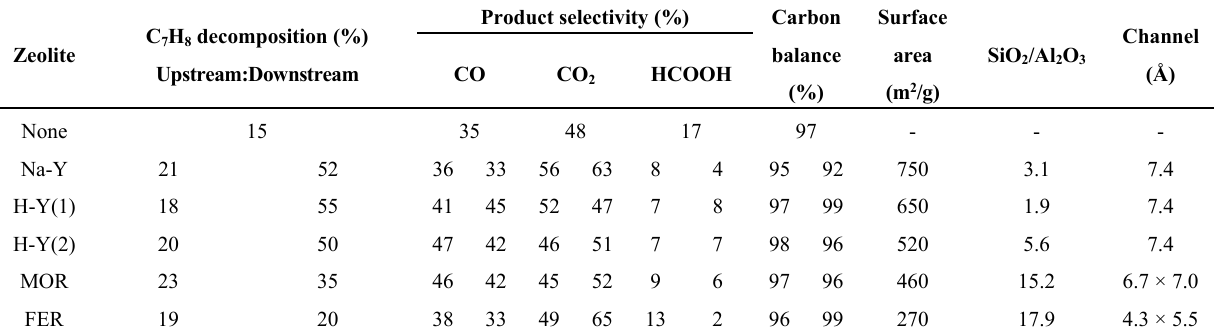
Table 1. Decomposition efficiency in hybrid plasma reactors and the properties of zeolites.